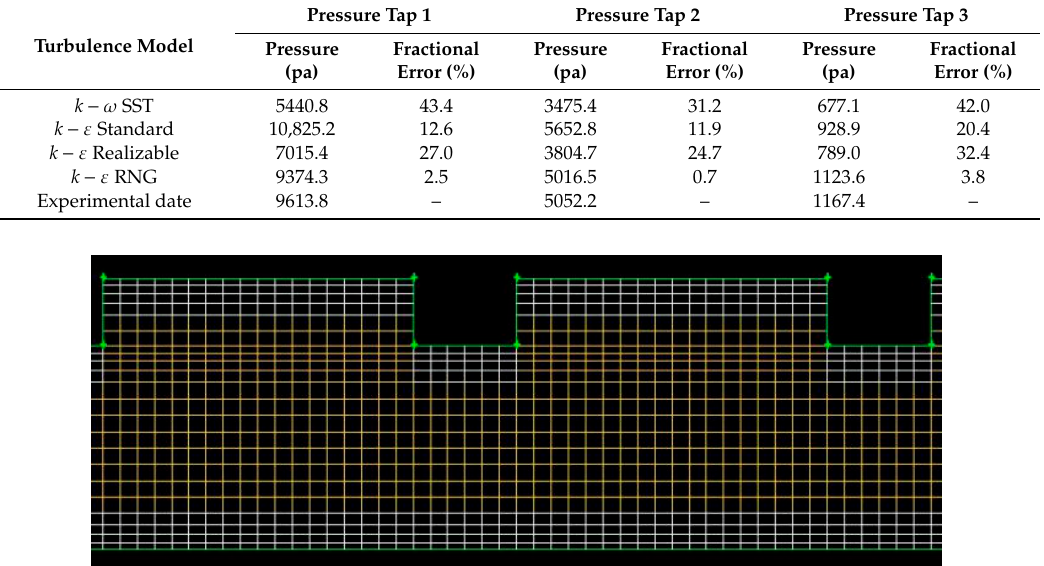
Table 2. Comparison between the calculated results of each turbulence model and the experimental data.